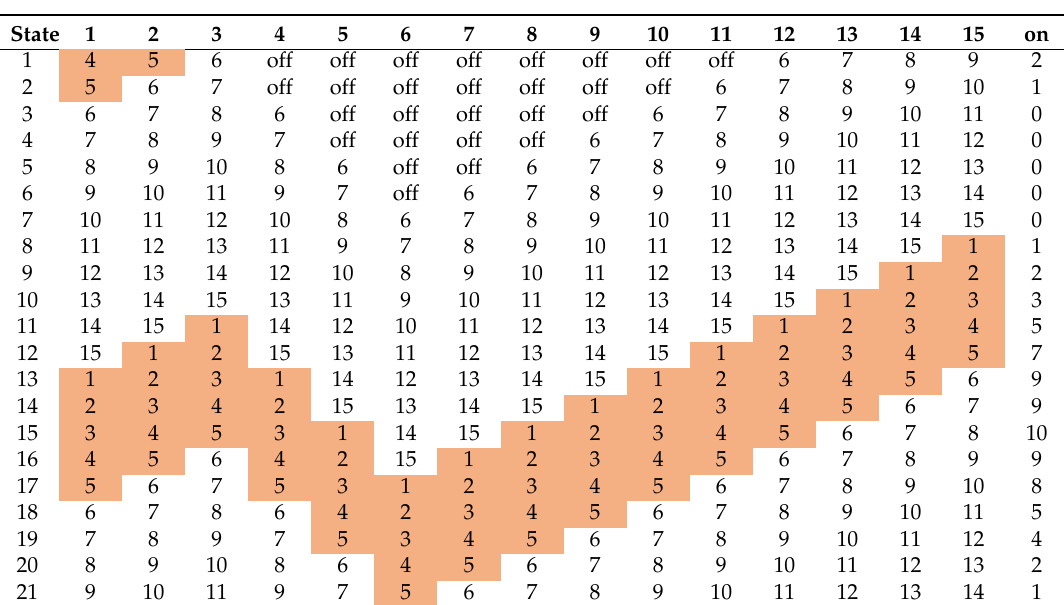
Table 2. Fifteen groups of load state distributions after temperature adjustment.